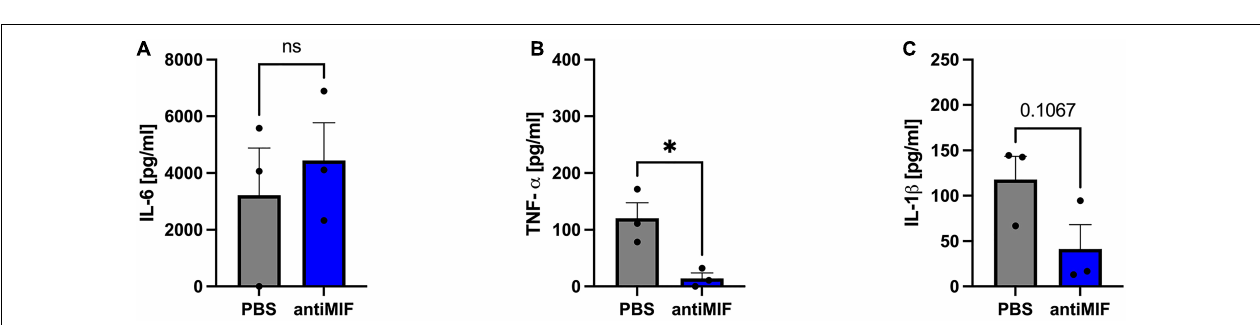
FIGURE 9 | Release of IL-6, TNF- α , and IL-1 β from ASCs from healthy donor site (Group A) following hypoxia and stimulation with recombinant human MIF. Cells were stimulated with 100 ng/ml of recombinant MIF and cultured in growth medium at normoxic oxygen levels of 21% O 2 or hypoxic oxygen levels of < 1% O 2 . Supernatants of ASCs were collected at 24 h after induction of hypoxia and ELISA was performed to assess cytokine secretion by ASCs under normoxic and hypoxic conditions. Results are displayed for (A) IL-6 ( n = 6), (B) TNF- α ( n = 6), and (C) IL-1 β ( n = 6). Data are mean values ± SEM (two-way ANOVA, Holm-Šídák’s multiple comparisons test, ∗∗ p < 0.01).